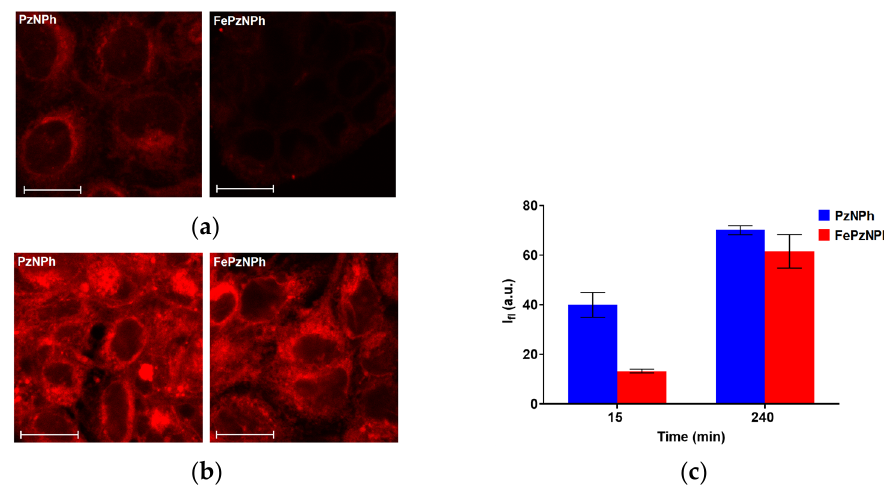
Figure 4. Analysis of the cellular uptake of PzNPh and FePzNPh . Representative confocal images of human epidermoid carcinoma A431 cells after 15 min ( a ) and 240 min ( b ) of incubation with PzNPh and FePzNPh (5 µM). Relative accumulation of PzNPh and FePzNPh after 15 and 240 min incubation, estimated from a confocal microscopy experiment ( c ) ( n ≥ 10). The values are given minus the background, which did not exceed 4 a.u. Scale bar 20 µm. The data are presented as the mean values ± SD.